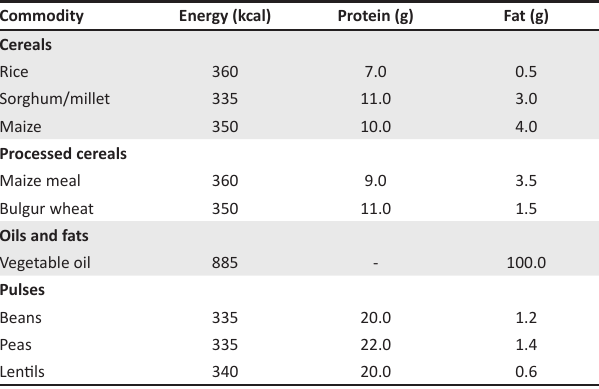
TABLE 1: Vulnerable Group Feeding Programme food basket. Commodity Energy (kcal) Protein (g) Fat